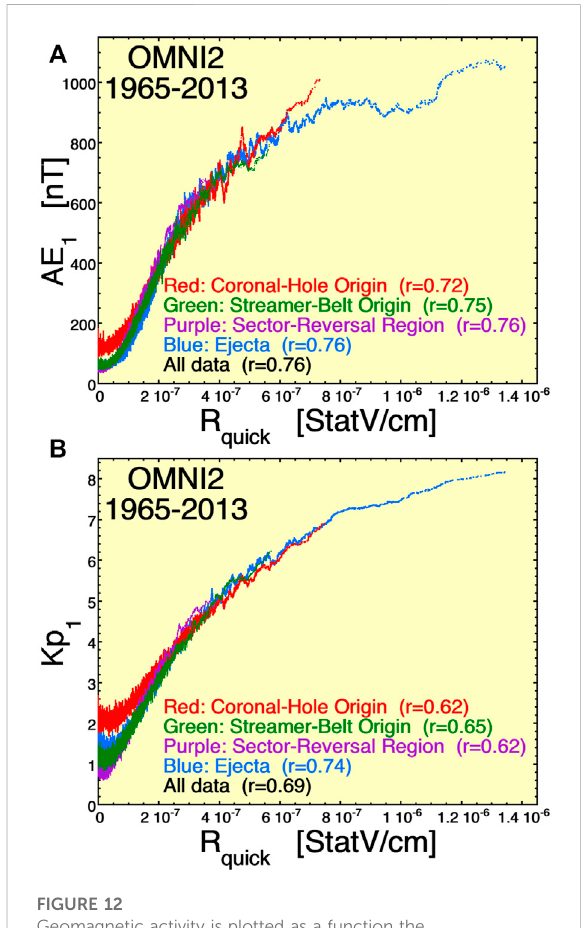
FIGURE 12 Geomagnetic activity is plotted as a function the reconnection driver function R quick separately for the four types of solar-windplasma.Panel (A) ploteAE 1 andpanel (B) plotsKp 1 .Only running averages of the individual hourly data points are plotted.